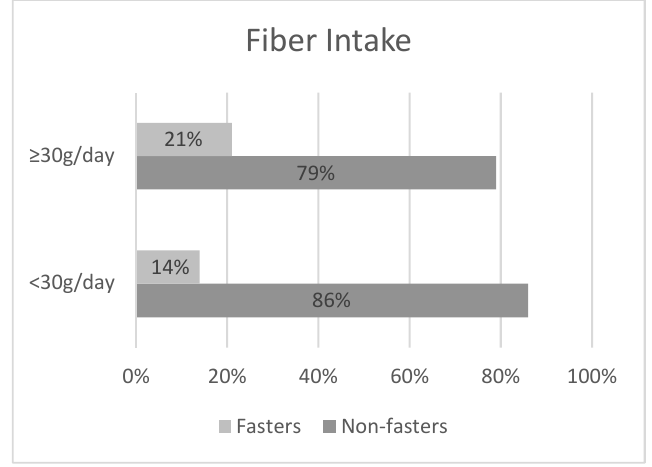
- - Figure 1. Bar chart for fibre consumption between fasters and non-fasters. Figure 1. Bar chart for fibre consumption between fasters and non-fasters. Table 2. Dietary fibre intake. The bar chart in Figure 2 shows that majority of participants (58%) had a ‘good’ con- sumption of fruit and vegetables, managing to consume approximately four or more por- tions of fruits and vegetables a day, compared to a lower percentage of non-fasters (42%). In addition, 21% of non-fasters consumed less than two portions of fruit and vegetables a day, compared to nine percent of fasters, showing that non-fasters have a poorer fruit and vegetable intake.